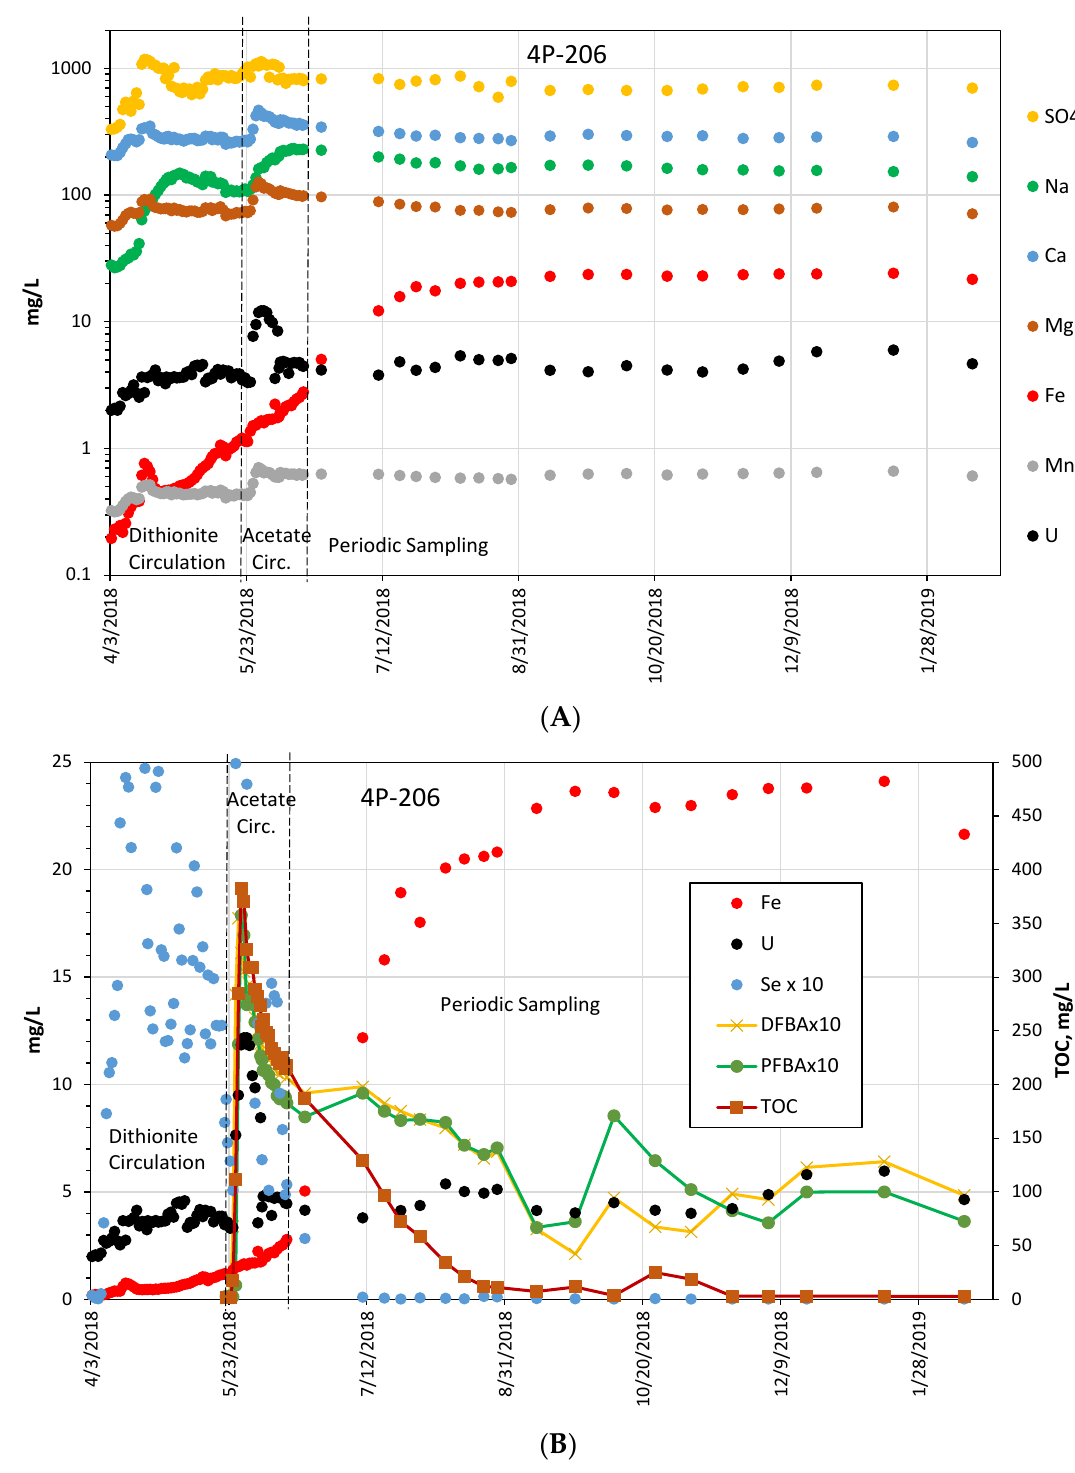
Figure A22. ( A ) Concentration histories of several key constituents in production well 4P-206 during the amendment test. ( B ) Concentration histories of redox-sensitive constituents (Fe(II), U, Se), TOC (as acetate surrogate), and tracers. Note that Se, difluorobenzoate (DFBA), and pentafluorobenzoate (PFBA) concentrations are multiplied by 10.